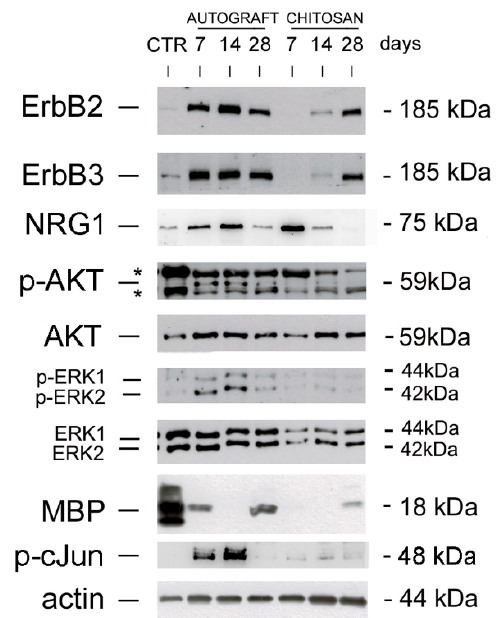
Figure 1. NRG1 and ErbB expression in autograft and chitosan groups. Western blot analysis of proteins extracted from healthy control nerves (CTR) and regenerating nerves belonging to autograft or chitosan groups withdrawn 7, 14, and 28 days after the repair and probed with antibodies for ErbB2, ErbB3, phospho-AKT, total-AKT, phospho-ERK, total-ERK, MBP, phospho-cJun; actin was used as a loading control. For NRG1, an antibody recognizing the C terminus fragment was used. Unspecific bands were identified with asterisks (*). Molecular weight (kDa) are shown on the